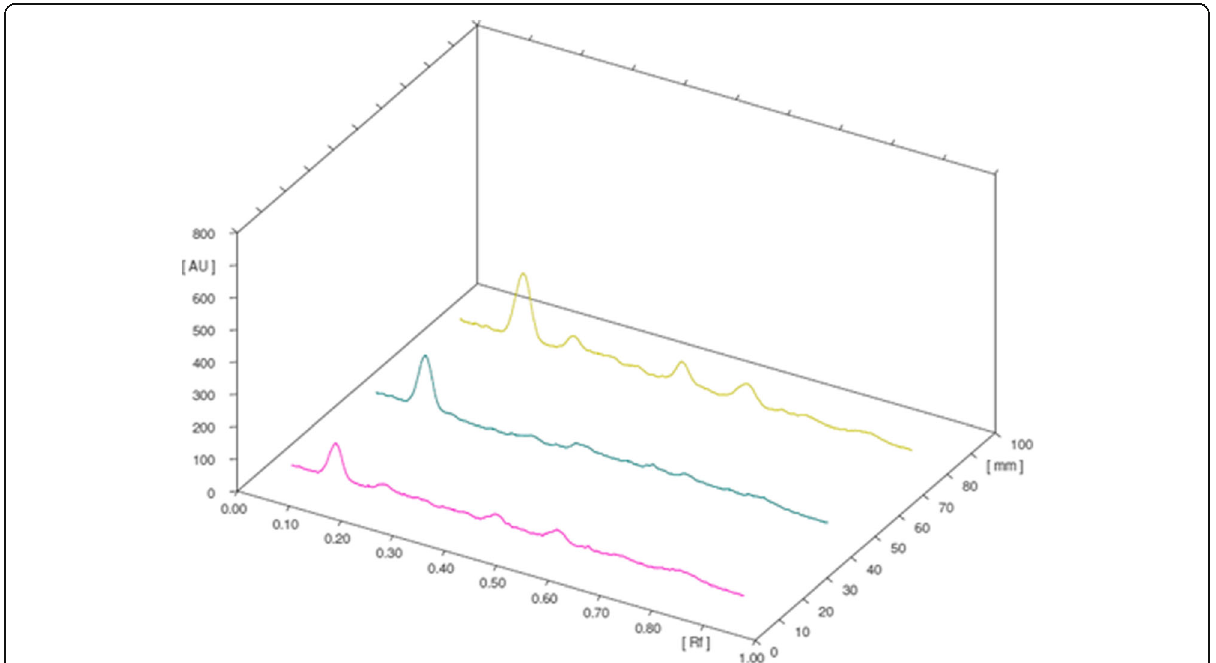
Fig. 1 HPTLC fingerprinting densitogram of C. melo fruit powder. Yellow line, ethanolic extract of C. melo ; blue line, standard kaempferol; pink line, toluene fraction of ethanolic